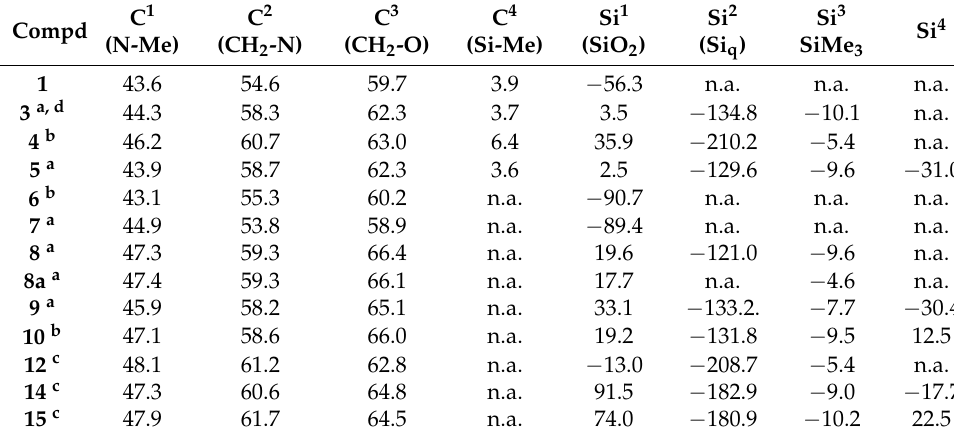
5 ppm shift to values around δ C2 = 59 ppm (Table 1). A similar trend is also visible for the oxygen-attached methylene units (C 3 ), which are found close to δ C3 = 60 ppm for 2 , 6 , and 7 but again experience a downfield shift to values around δ C3 = 65 ppm for the silyl substituted examples. Somewhat unexpected silanide formation, such as is the case for 4 , 12 , 14 , and 15, does not really affect the chemical shifts of C 2 and C 3 . The signal for the methyl group at the silocane Si at compounds 2 – 5 , occurs close to 4 ppm for the neutral compounds 2 , 3 ,and 5 but shifts slightly to 6.4 ppm for the silanide 4 . Table 1. 13 C and 29 Si NMR properties.